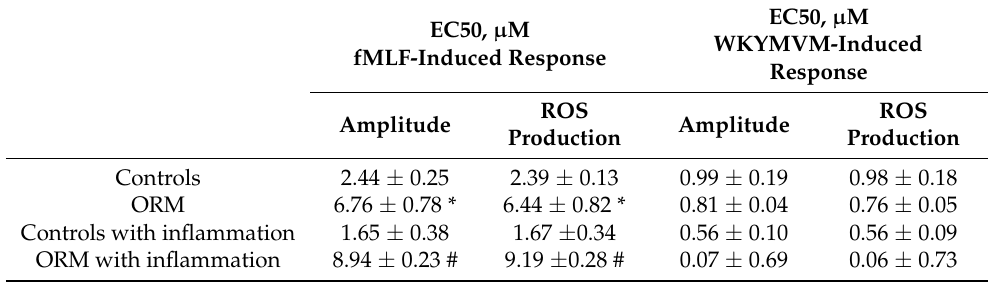
Table 2. EC50 values for FPR ligands initiated respiratory burst in murine bone marrow granulocytes.